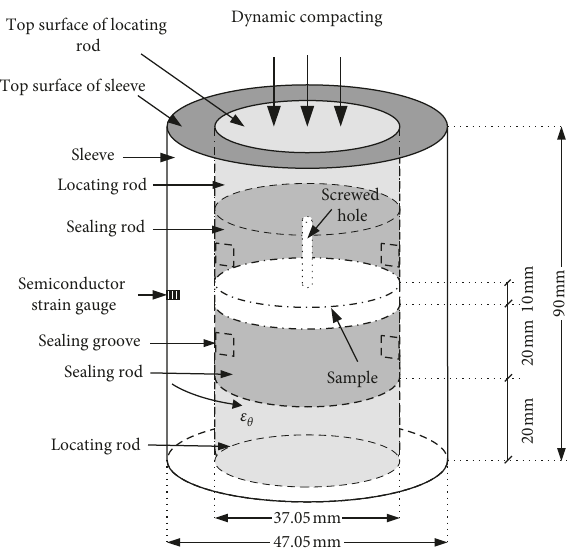
Figure 4: Schematic diagram of the sample in the container.